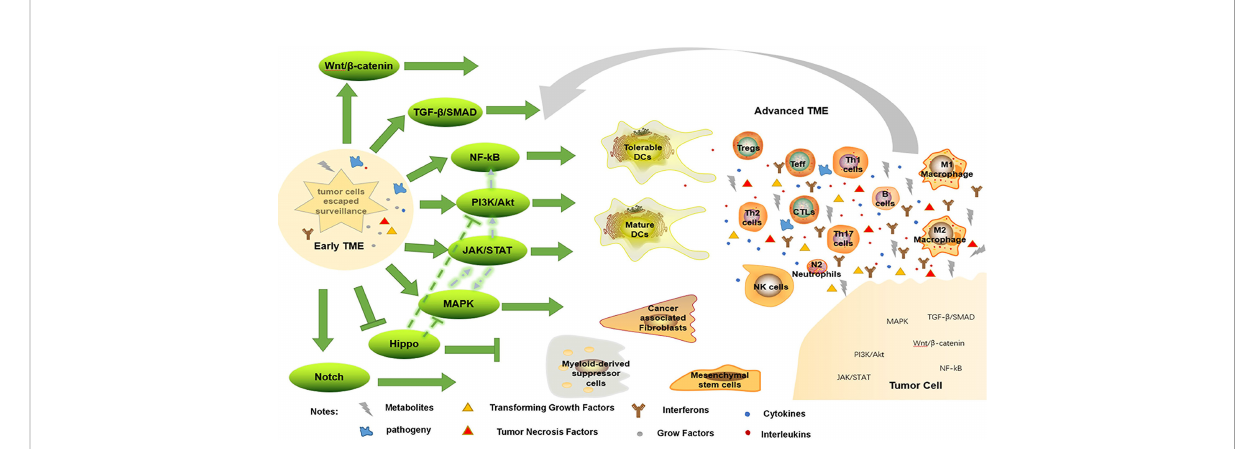
FIGURE 2 Immune evasion by changing TME. When tumor cells escape immune surveillance, they form early TME, enhancing immunosuppressive environment, weakening anti-tumor response, and further promote tumorigenesis through a variety of signaling pathways. Conversely, this advanced TME promotes tumor progression through these